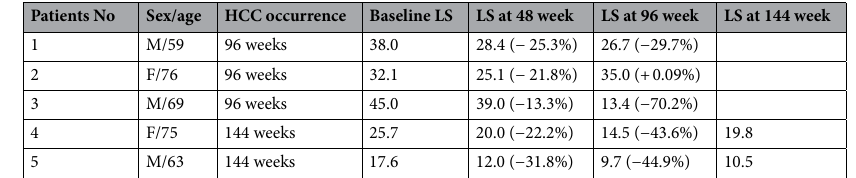
Table 4. Characteristics of patients with HCC development. HCC, hepatocellular carcinoma; LS, liver